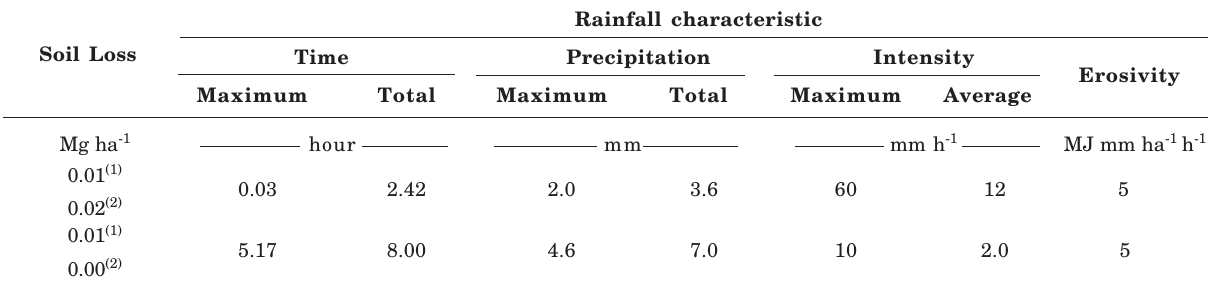
(1) Data of the typic dystrophic Tb Haplic Cambisol (CXbd); (2) Data of the typic dystrophic Red Latosol (LVdf).